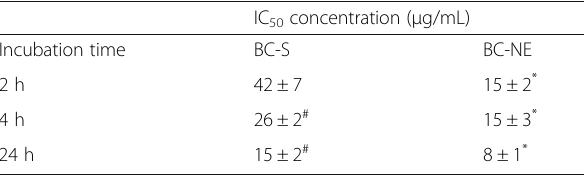
Table 2 IC 50 values for BC-S and BC-NE venoms ( n = 4) on HEK- 293 cell